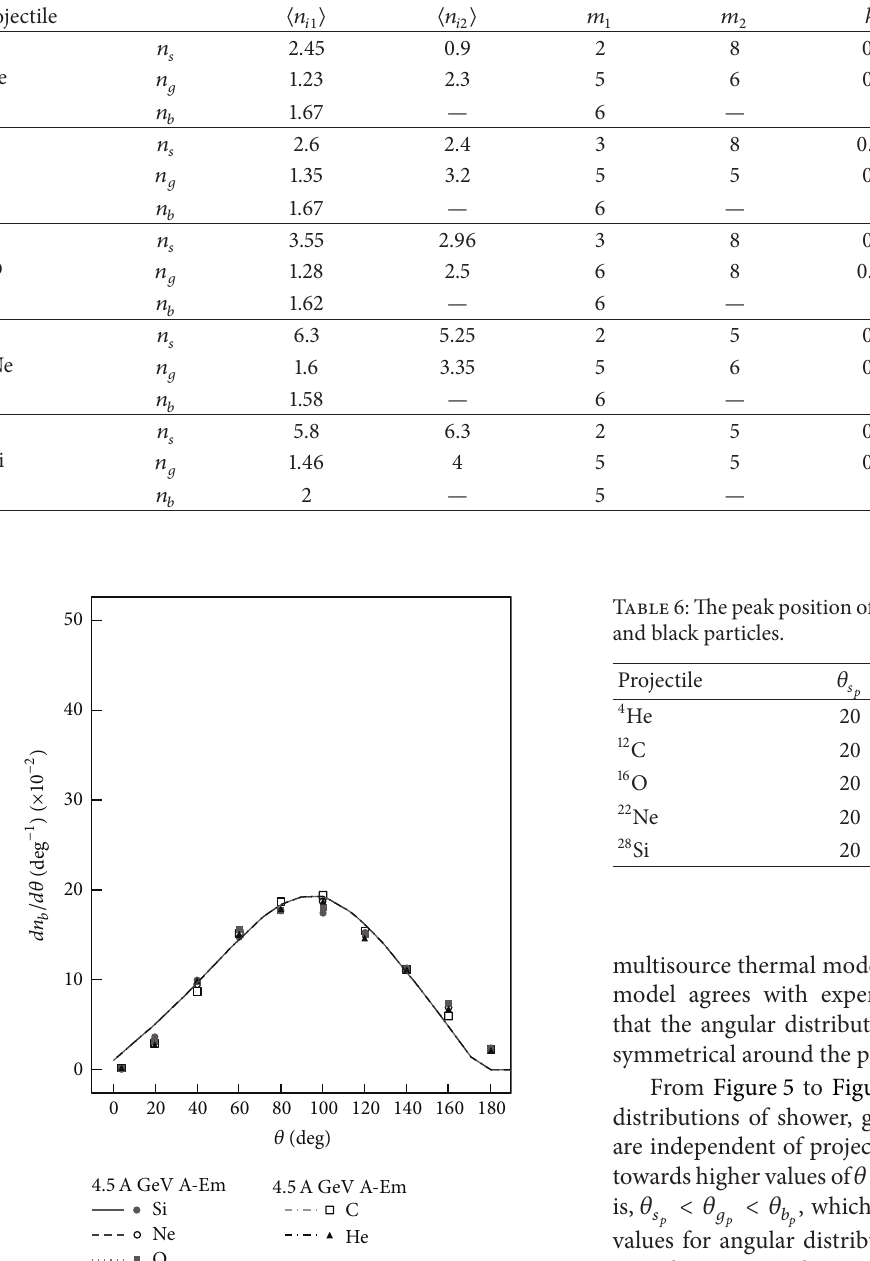
Table 5: Parameter values for multiplicity distributions for shower, grey, and black particles. The values of ⟨𝑛 𝑖1 ⟩ , ⟨𝑛 𝑖2 ⟩ , 𝑚 1 , 𝑚 2 , and 𝑘 1 , 𝑘 2 for 4 He-, 12 C-, 16 O-, and 28 Si-AgBr at 4.5 AGeV/c and 22 Ne-AgBr at 4.1 AGeV/c.